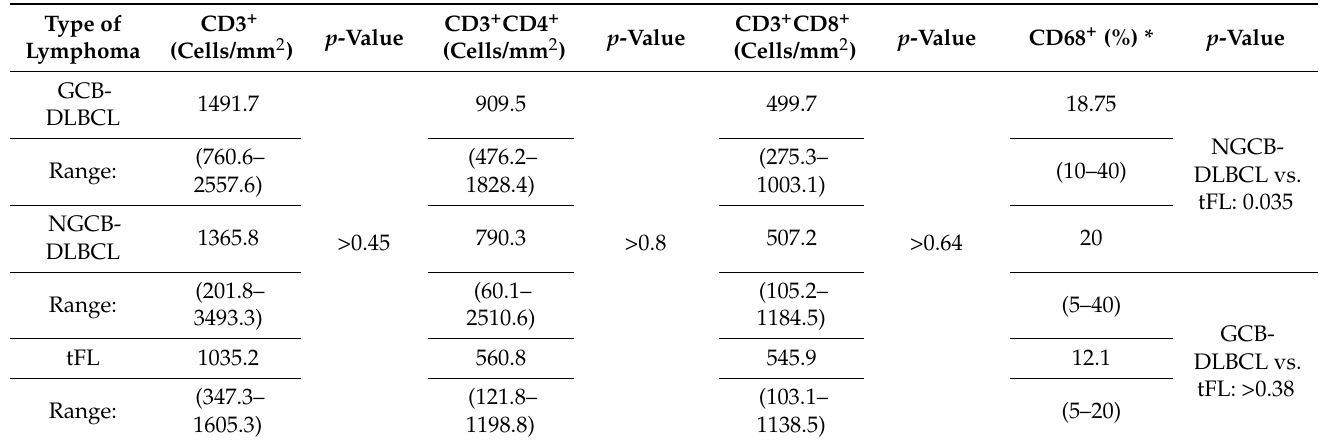
Table 1. Analysis of intratumoral T-cells (CD3 + ), T helper (CD3 + CD4 + ), cytotoxic T (CD3 + CD8 + ) cells and macrophages (CD68 + ) determined by multicolor-immunofluorescence staining on selected